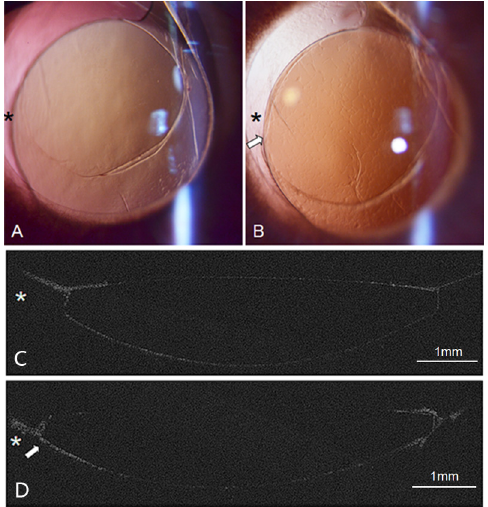
Fig 6. Slit lamp image of a posterior capsule and an OCT image of capsular bend of an incompletely overlapped eye 7 days (A and C) and 28 days postoperatively (B and D). (A and C) On day 7 postoperatively, the capsule was smooth, no opacity was present, and both sides formed anterior adhesion types. (B and D) On day 28 postoperatively, the temporal side (black and white asterisk) exhibited an undesirable overlap, abundant proliferation, and migration of LECs into the posterior capsule. The detachment and funnel adhesion types emerged at the temporal and nasal sides, respectively. Increased thickness of the posterior capsule (white arrow) was apparent in both slit lamp and OCT